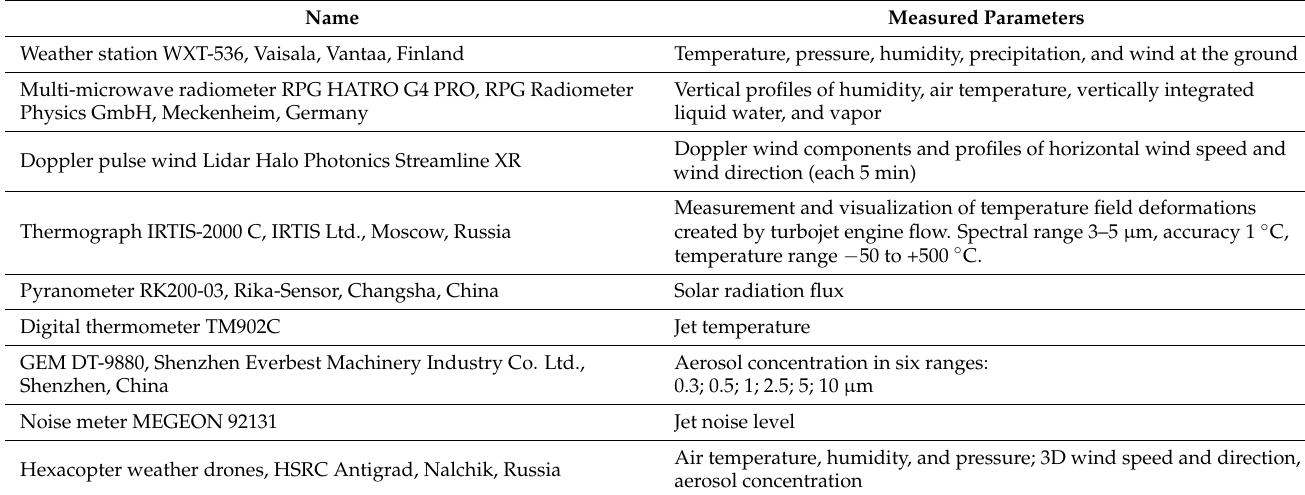
Table 2. Equipment for instrumental control of